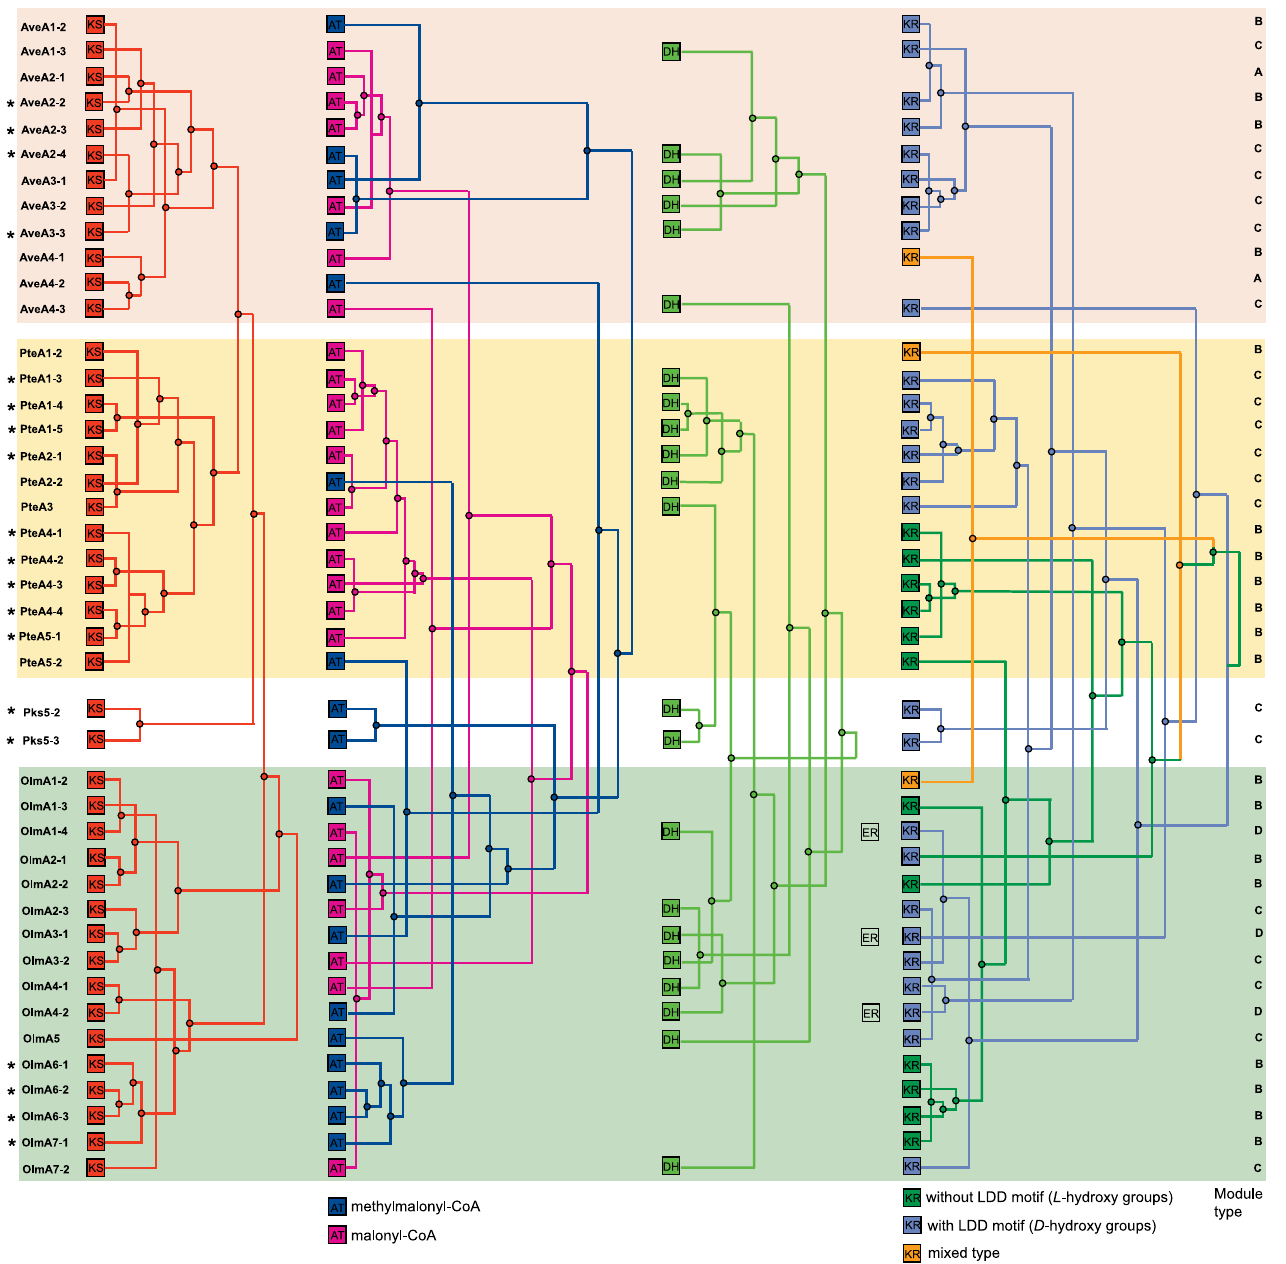
Figure 4. Phylogenies of the Different PKS Domain Types from S. avermitilis Projected onto the Cluster Structure Modules that show complete congruity in all their domains are marked by asterisks on the left. The different subtypes of AT as well as KR domains are represented by different colors. The module types specified on the right are as in Figure 1. DOI: